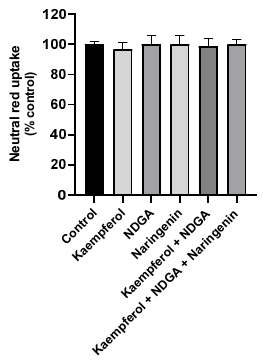
Figure 4. Cytotoxicity of the free natural compounds (alone or in combination) evaluated in HaCaT cells by the NR uptake assay 24 h after exposure to a 0.81 μ g/mL concentration. Results are expressed as mean ± SD from four independent experiments performed in triplicate. Statistical comparisons were made using one-way ANOVA followed by the Dunnett’s multiple comparisons test. In all cases, p values < 0.05 were considered significant.